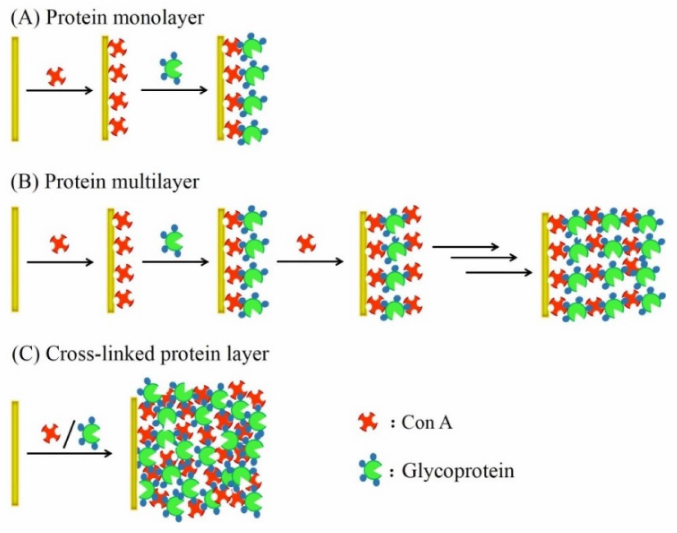
Figure 1. Possible routes for immobilization of glycoproteins by Con A on the surface of solid surface. ( A ) Monomolecular layer of glycoprotein; ( B ) layer-by-layer-deposited multilayer film of glycoprotein; and ( C ) cross-linked multilayer film of